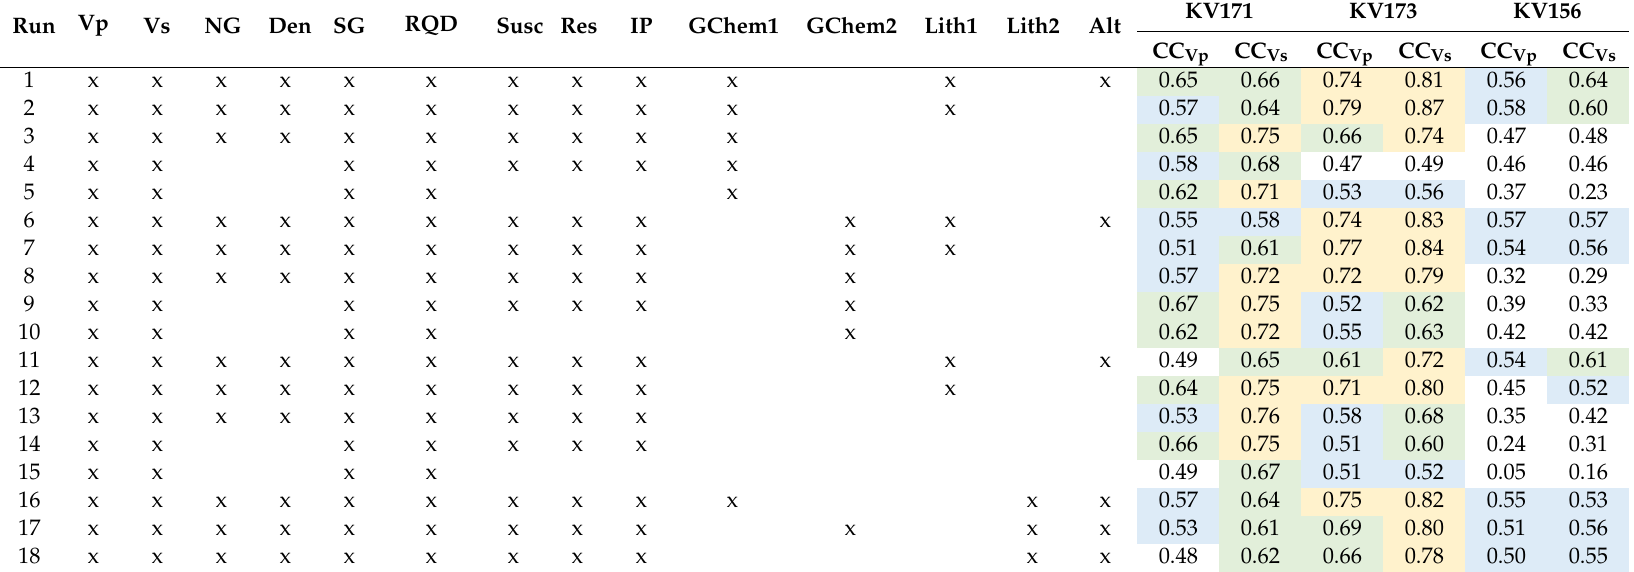
Table 2. Di ff erent sets of parameters used for di ff erent SOM runs (1–18) to predict missing seismic velocity values for boreholes KV171, KV173, and KV156. Correlation coe ffi cients between actual measured and predicted SOM logs are shown for both Vp (CC Vp ) and Vs (CC Vs ). The runs that resulted in correlations greater than 0.70 are highlighted in yellow, those with correlation greater than 0.60 but smaller than 0.70 are highlighted in green, and those with correlations greater than 0.50 but smaller than 0.60 in blue. Predicted velocities from run 9 are shown in Figures 5–7. Den = density; NG = natural gamma; Susc = magnetic susceptibility; Res = electrical resistivity; GChem1 = geochemical parameters Ni, Cu, Au, Pd, Pt, Fe, S, Co, Cr, Al, Ca, Mg, and Na; GChem2 = geochemical parameters Ni, Cu, Au, Pd, Pt, Fe, S, C, and Cr; Lith1 = lithology; Lith2 = lithology without metaperidotite label; Alt = alteration; x = parameter included in the